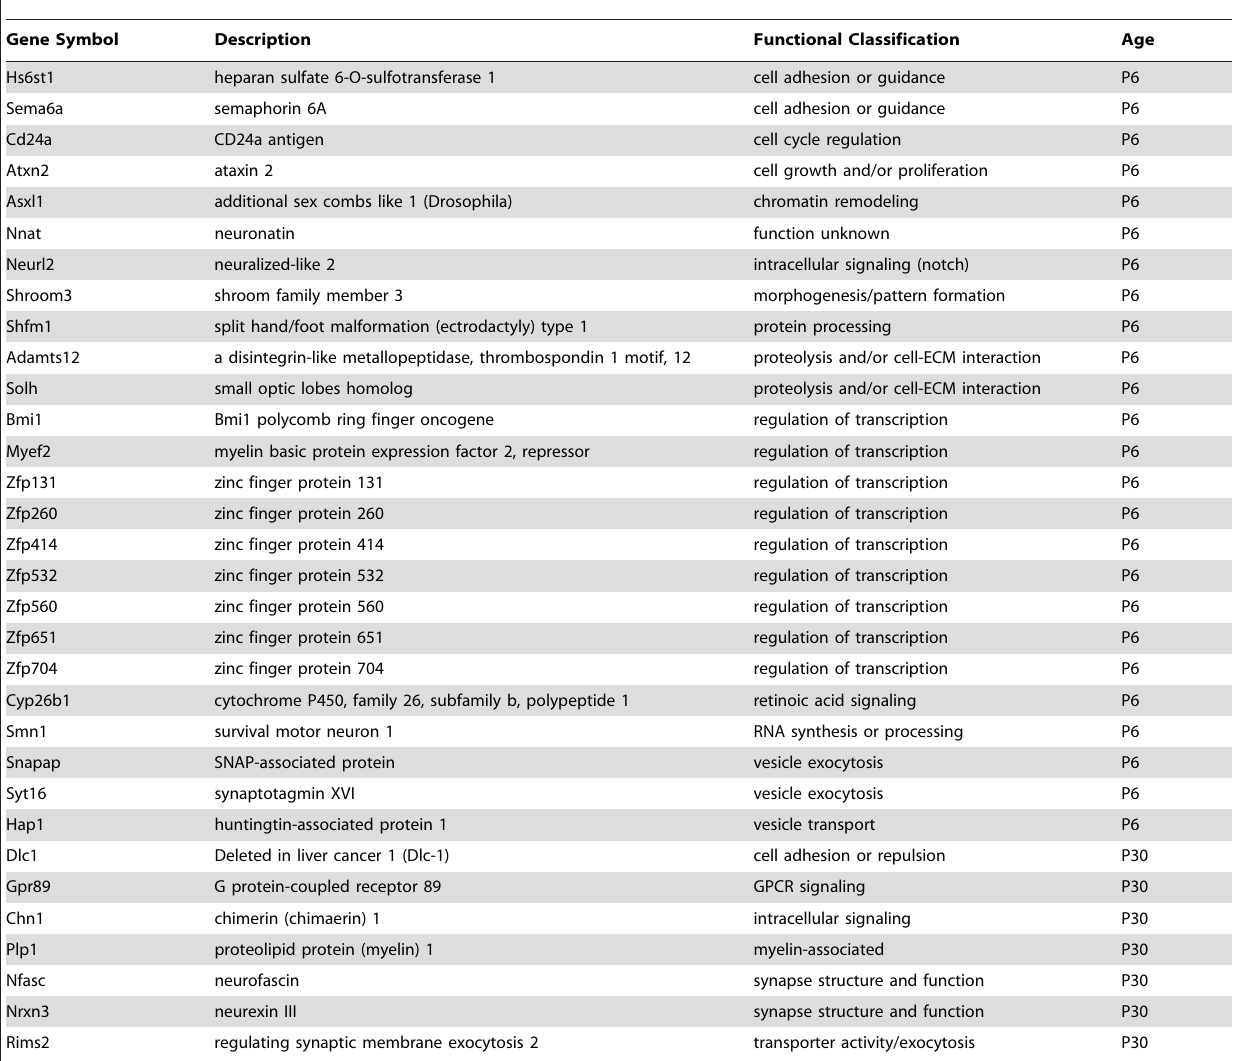
Table 5. Differentially expressed (P6 vs. P30) genes in Bergmann glia not previously known to be present in